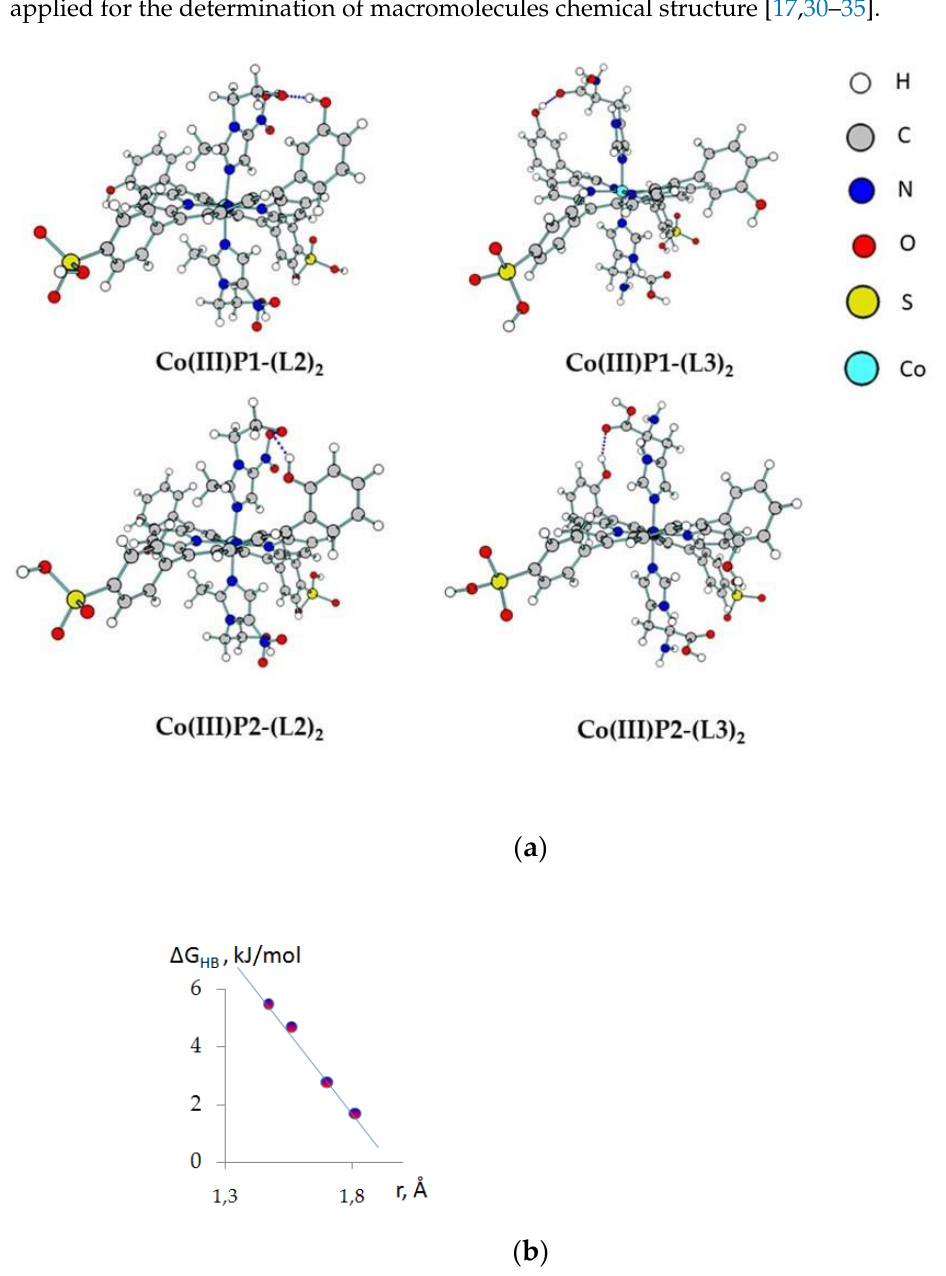
Figure 4. Optimized structures of bis -axial complexes ( a ) and dependence of the length of the additional hydrogen bond in these complexes with ∆ G HB , calculated from experimental data ( b ). Thus, the strongest binding of the ligand to porphyrin (E int ) corresponded to the smaller value of the hydrogen bond length between them (r(OH…O = L)). Therefore, the strongest bonds are formed when porphyrinate Co(III)P2 binds the metronidazole (L2). The lengths of the formed hydrogen bond and the energies of the intermolecular interac- tion of the bis -axial complex are in good agreement with the values of the energies of hydrogen bonds determined from the formation constants of the Co(III)P-(L)(H 2 O) com- plexes (Figure 5).